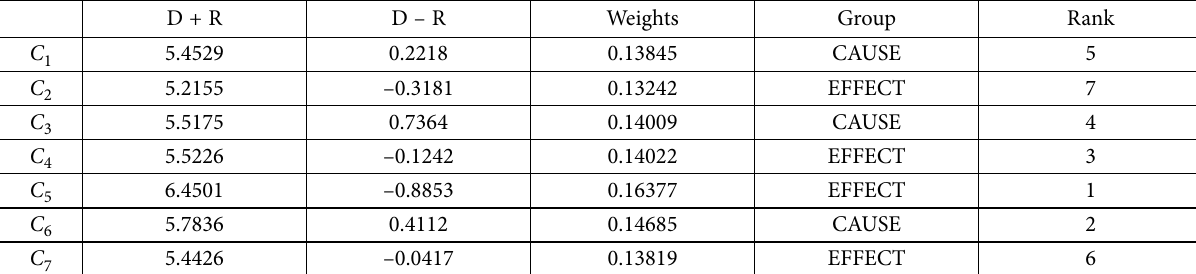
Table 5. The realisation of the best and worst criteria and cause & effect groups